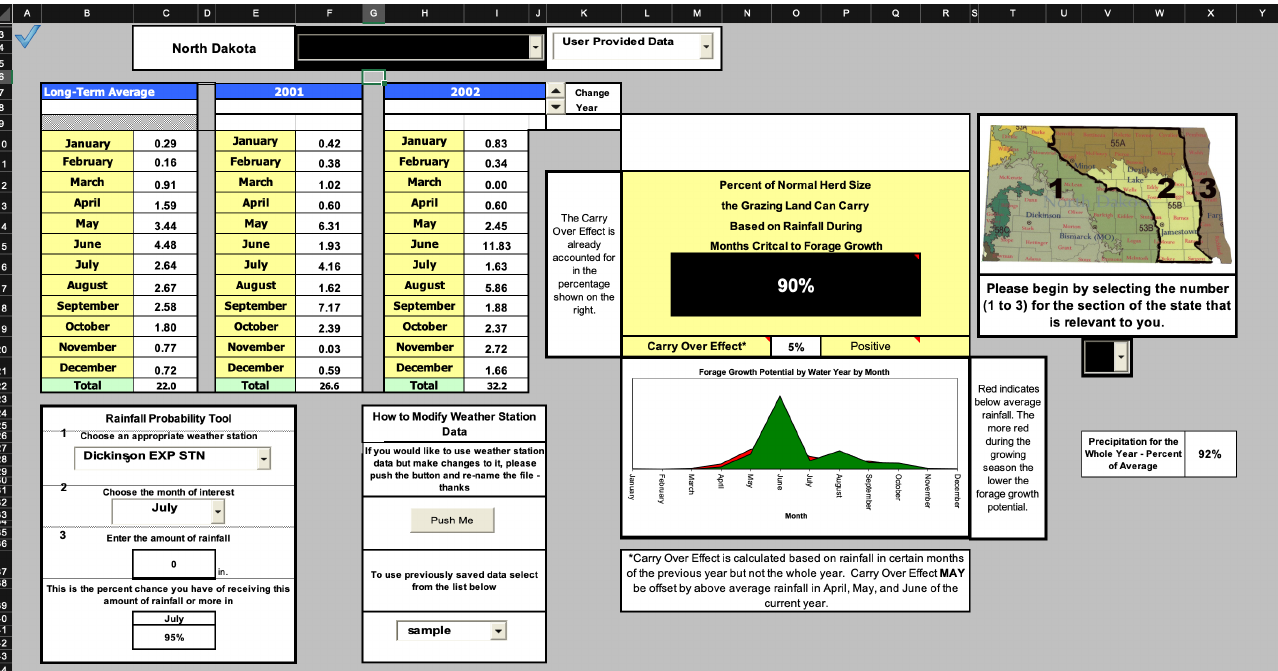
Figure 5. Previous version of the North Dakota Drought Calculator (NDDC) rainfall input page for predicting forage growth potential from three growth zones. The colored cells in the screenshot were meant to draw the attention of the users to various inputs and